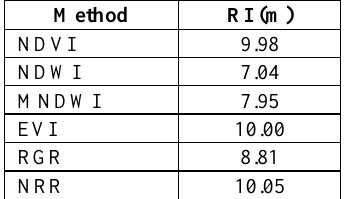
Table 4. RI values for the extracted coastlines using manually achieved coastline (based on visual interpretation of RGB composition) as reference.